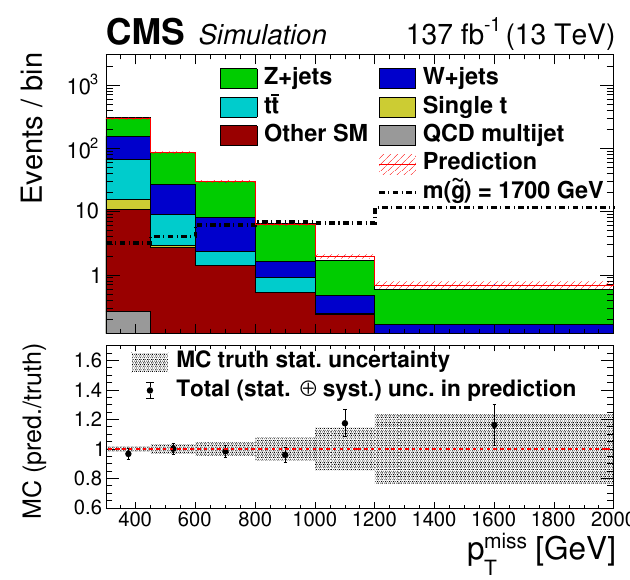
Figure 6 . Results of the closure test in which the background estimation method based on control samples in data is applied to simulation and compared with the direct yield, in the analysis search bins. Expected signal contribution for one example mass point is also shown. The lower panel shows the ratio of the prediction to the direct yield. The gray band shows the statistical uncertainty in the direct yield, and the error bars on the points represent the total uncertainty in the